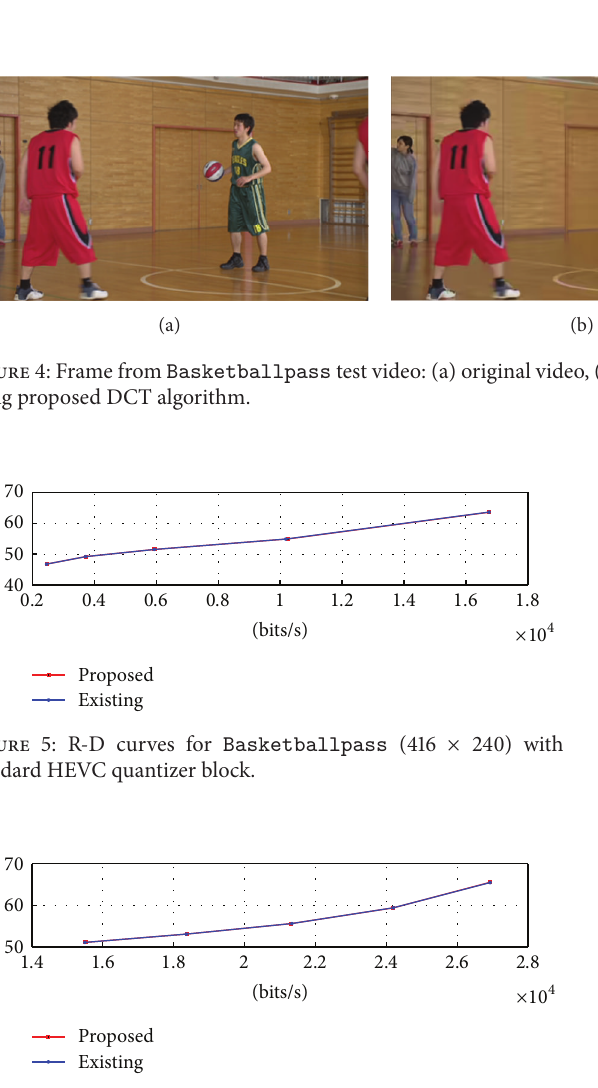
Figure 6: R-D curves for BlowingBubbles (416 × 240) with standard HEVC quantizer block.